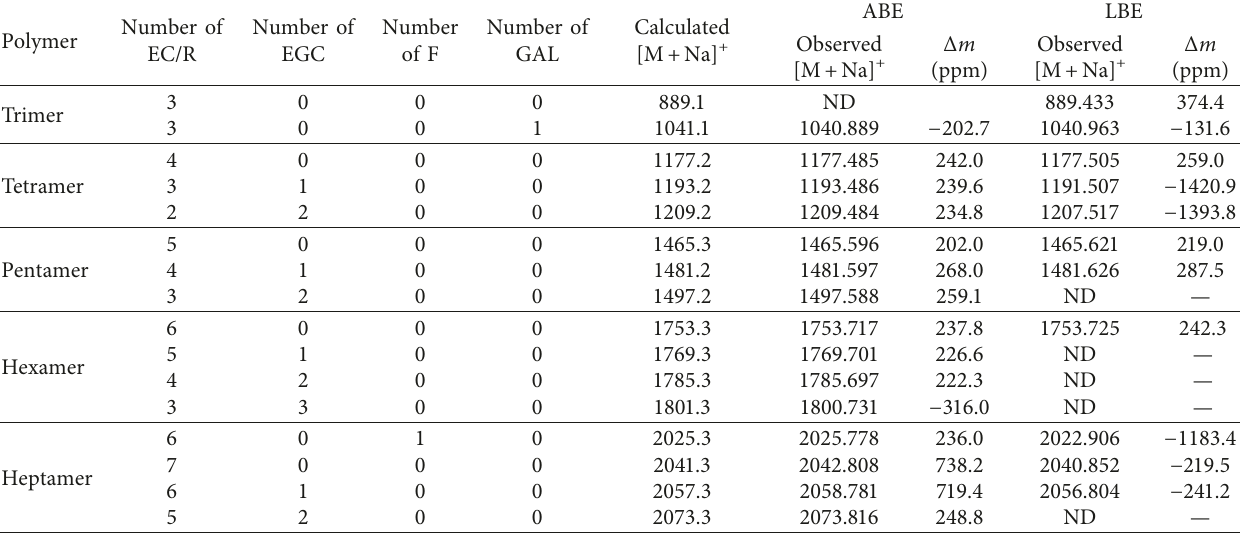
Table 2: PAs from ABE and LBE detected by MALDI-TOF/TOF MS.